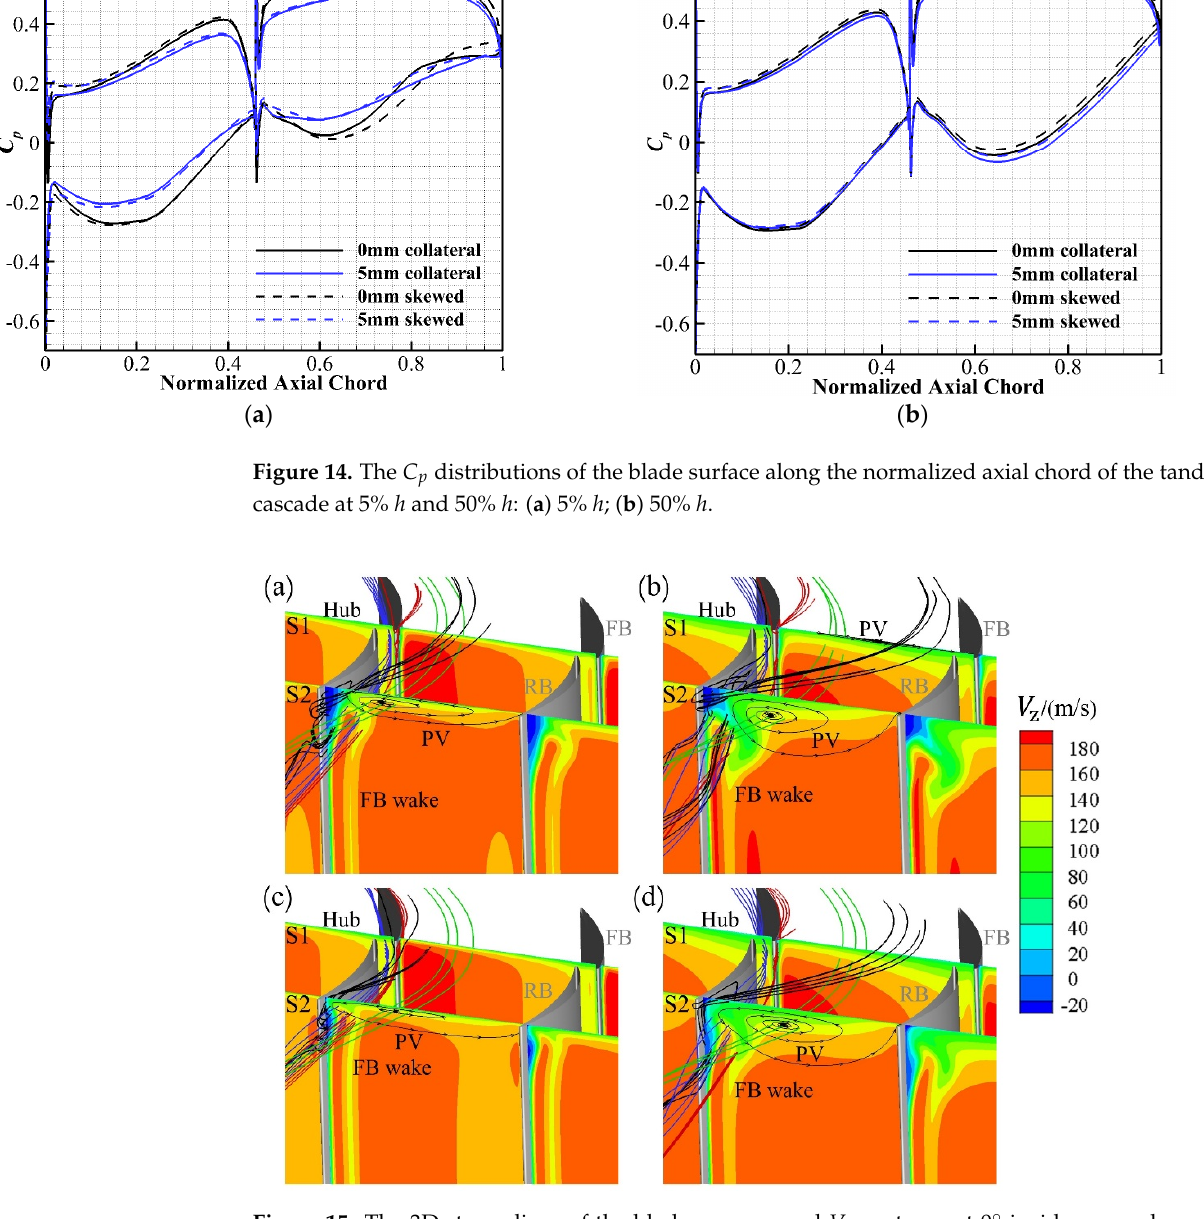
Figure 14. The 𝐶 (cid:3043) distributions of the blade surface along the normalized axial chord of the tandem cascade at 5% h and 50% h : ( a ) 5% h ; ( b ) 50% h .